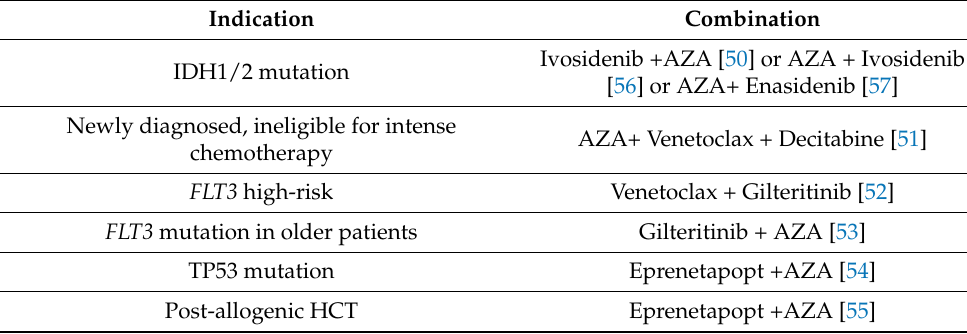
Table 3. Emerging combined target therapies.